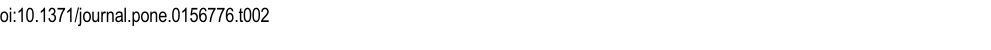
Figures in the table are rounded to two signi fi cant fi gures. Numbers in parentheses represent uncertainty